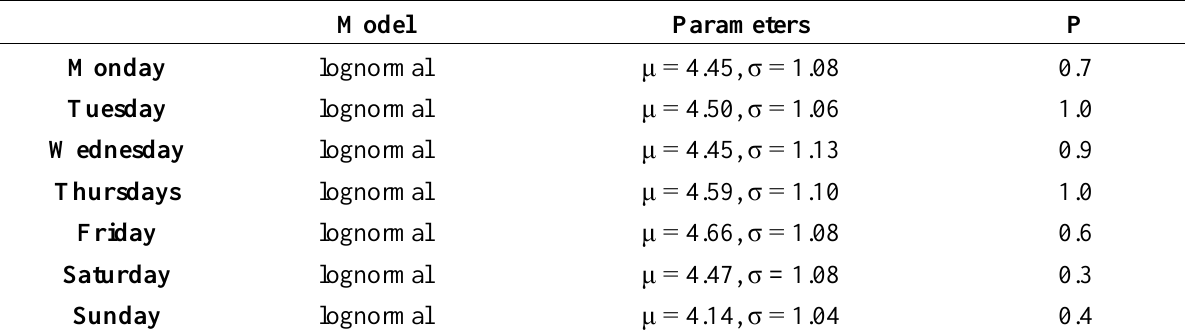
Table 2. Heavy-tailed distribution of human activities on a daily